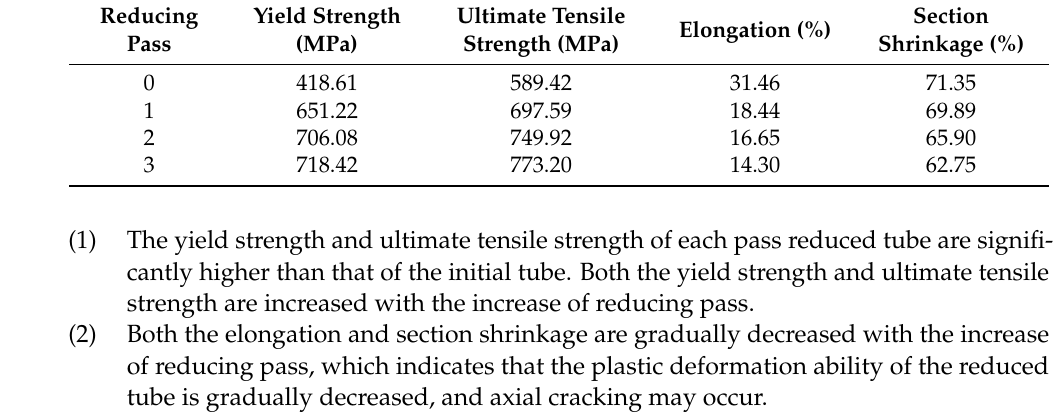
Figure 15. Finite element model.